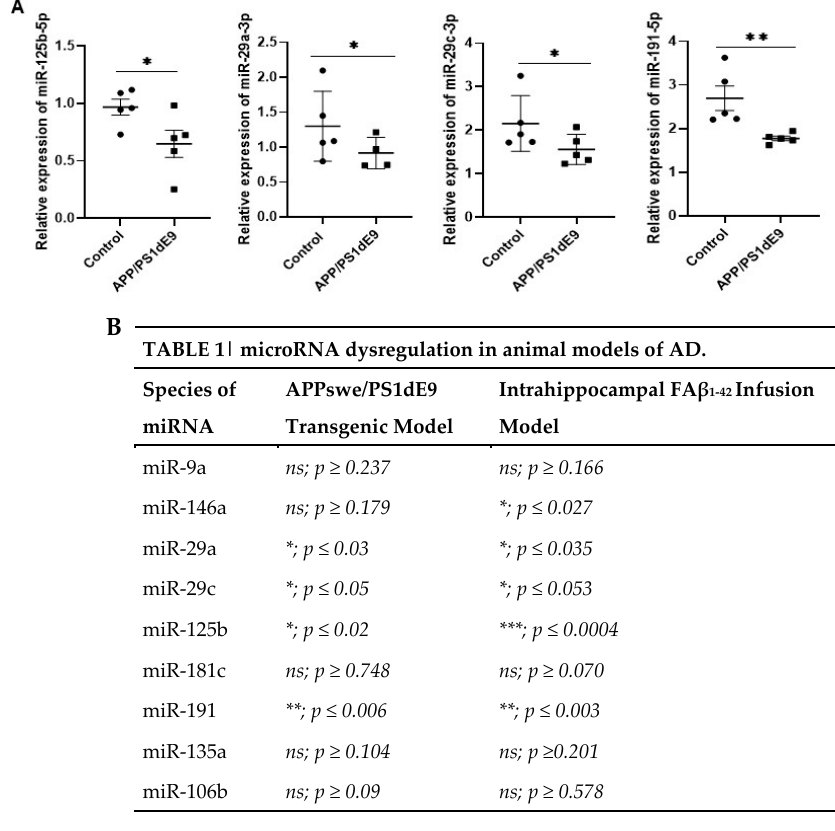
Figure 6. Relative expression of circulating miRNA-125b-5p, miRNA-29a, miRNA-29c, and miRNA- 191-5p in serum of APP swe /PS1 dE9 transgenic animal model of AD. ( A ) Serum samples from trans- genic mice at 15 months of age were extracted and processed for miRNA detection by qRT-PCR. Data are represented as mean ± SEM of 5 sera samples performed in triplicate. ( B ) Table illustrating the statistically significant differences in terms of relative expression of miRNAs between the FA β 1–42 - infused animal model (day 21) and the APPswe/PS1dE9 transgenic animal model of AD. Statistical comparisons between the transgenic and control group were performed using the Mann–Whitney test. * p ≤ 0.05, ** p ≤ 0.01, *** p ≤